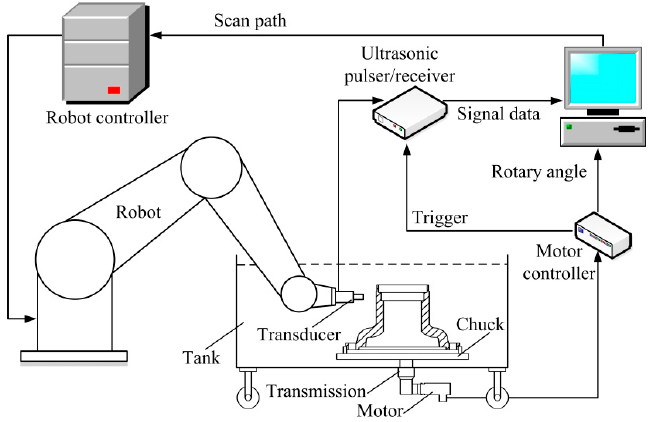
Figure 4. Configuration of the robot-assisted ultrasonic testing (UT) system.